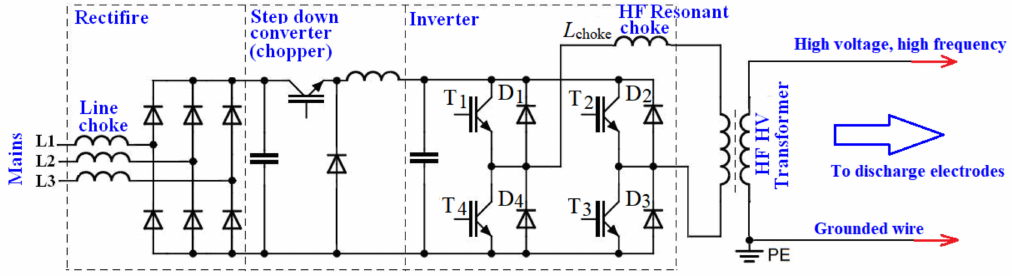
Figure 1. Schematic diagram of the power converter circuit used in the developed technological